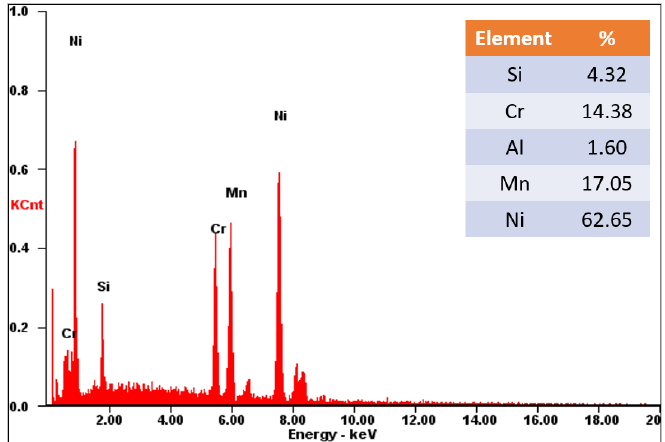
Figure 3. EDX spectrum for the newly obtained alloy with chemical composition obtained.